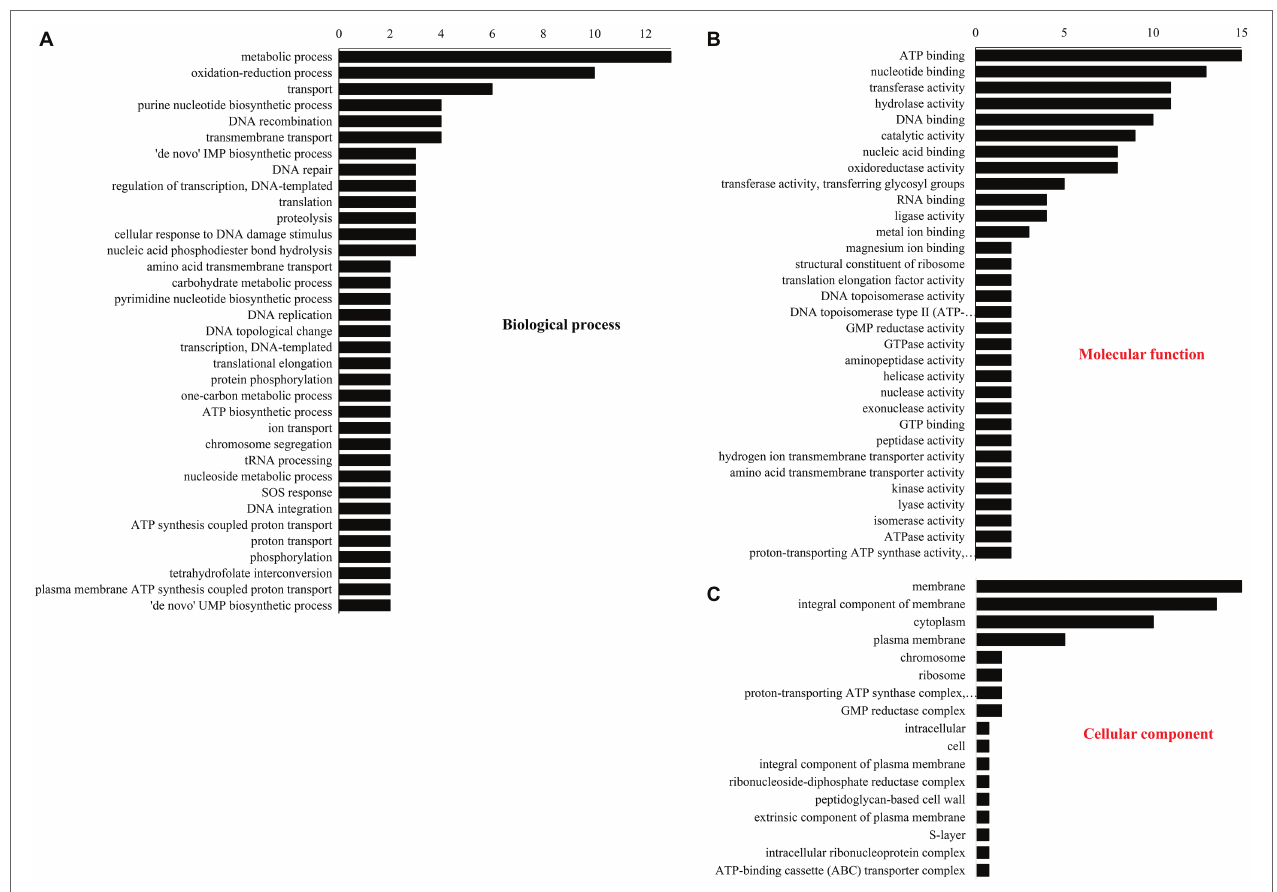
FIGURE 3 | Gene ontology classification of different proteins. (A) Biological process, (B) molecular function, and (C) cellular component.